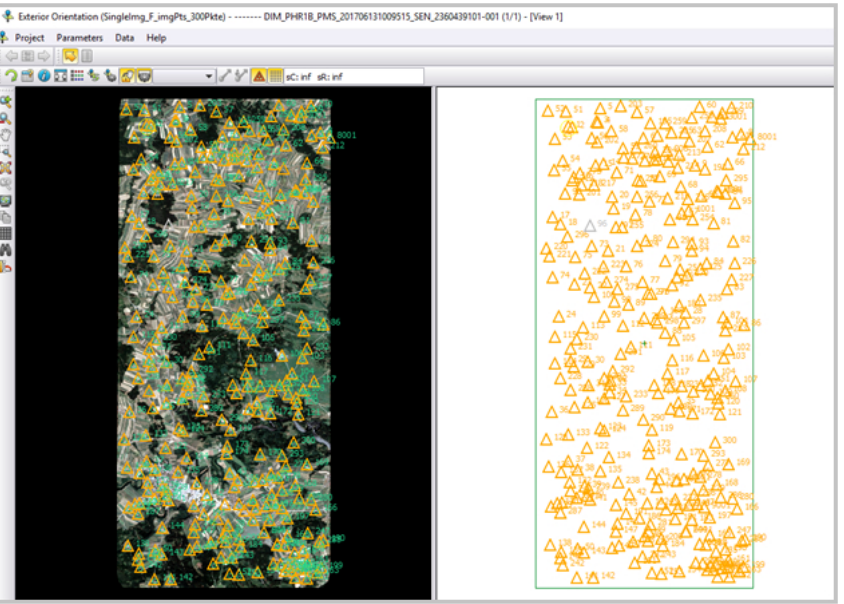
Figure 4. Overview of the 300 manually measured GCPs’ distribution in Match-AT